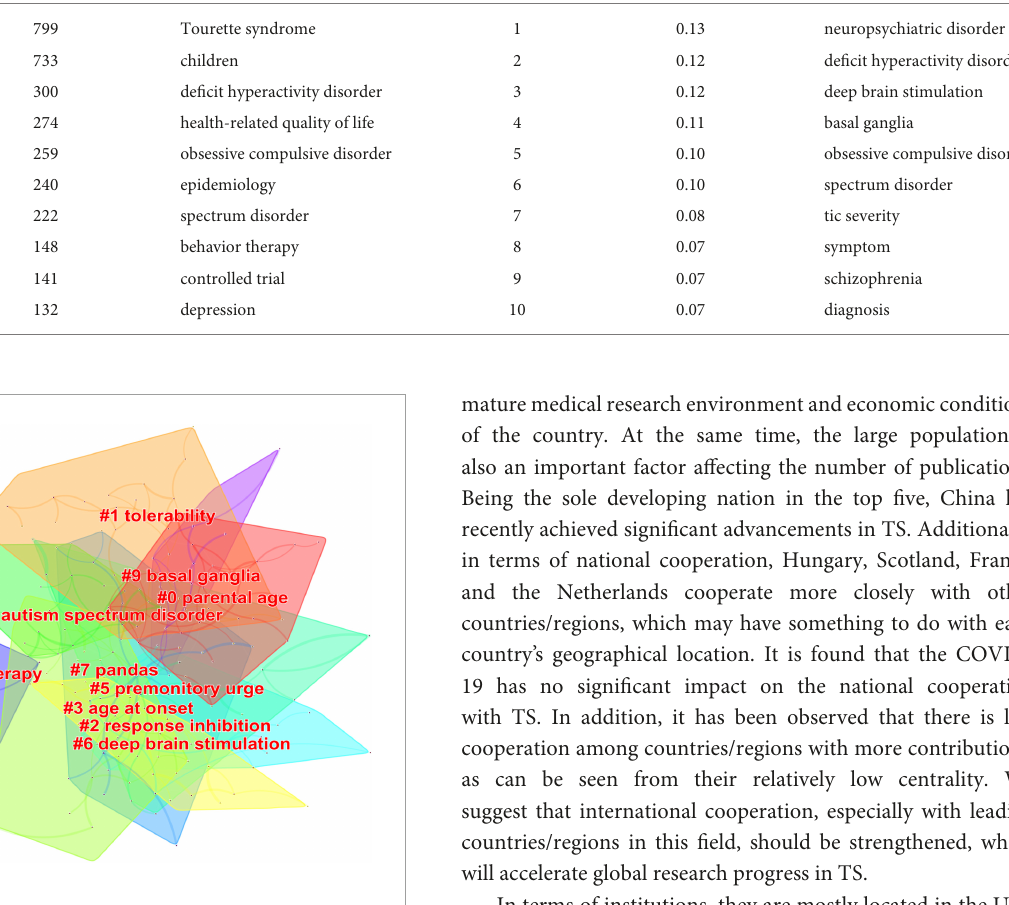
FIGURE6 Keywords cluster analysis co-occurrence map related to Tourette Syndrome (TS) in children research from 2011 to